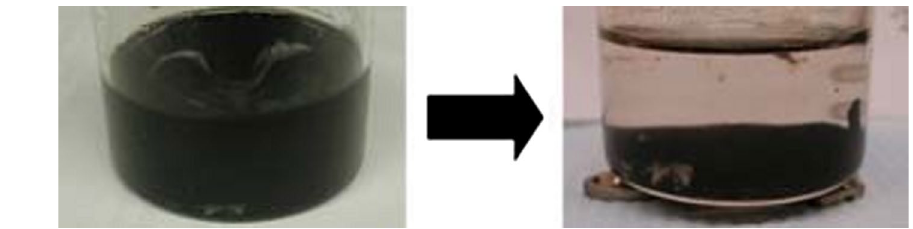
Fig. 2 Separation of MZN using an external stirred